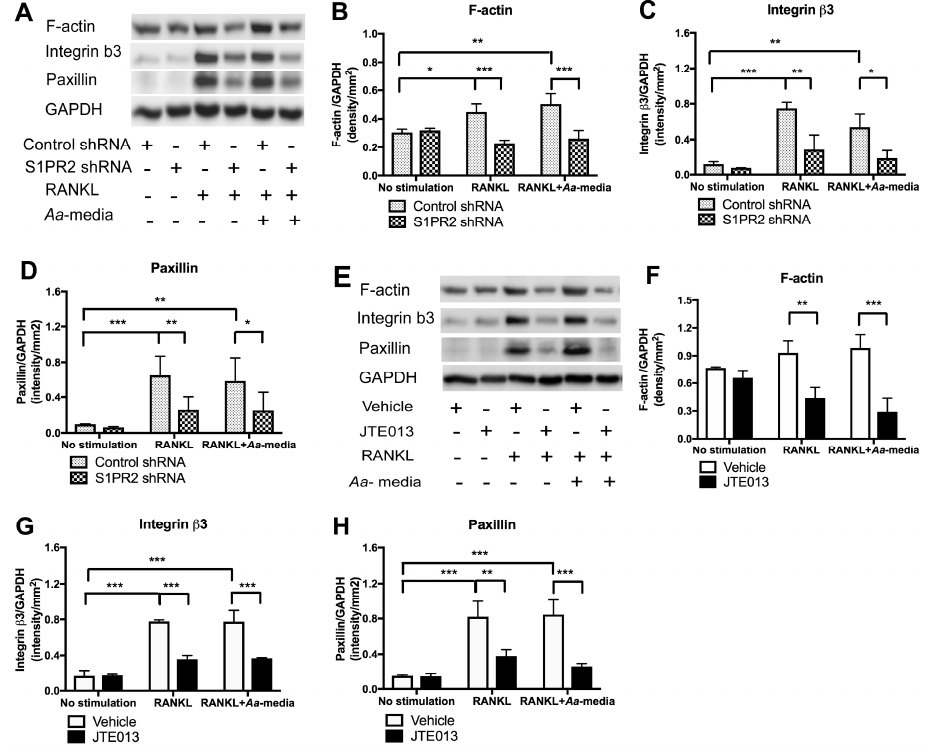
Figure 7. S1PR2 regulates podosome adhesive protein F-actin, integrin β 3 , and paxillin levels induced by RANKL with or without co-stimulated by Aa -stimulated media. Murine BMMs were treated with control shRNA/S1PR2 shRNA for one day or treated with vehicle/ JTE013 for 30 min. Then, cells were cultured in media containing M-CSF (50 ng/mL) alone or M-CSF with RANKL (250 ng/mL) for two days. On the third day, the media was changed with or without RANKL and/or JTE013. Some of the cells were co-cultured with both RANKL and Aa -stimulated media ( Aa- media, 200 µL/mL) for another day. ( A ) and ( E ) F-actin, integrin β 3, paxillin, and GAPDH protein expressions were evaluated by western blot. ( B ) and ( F ) F-actin protein density, ( C ) and ( G ) integrin β 3 protein density, and ( D ) and ( H ) paxillin protein density were analyzed and normalized by GAPDH protein expression. (* p < 0.05, ** p < 0.01, *** p < 0.001).